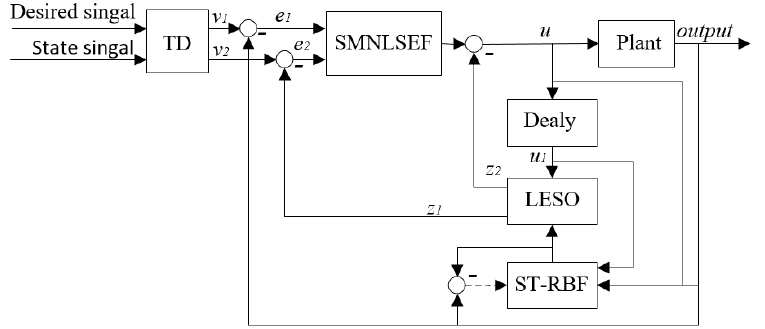
Figure 2. Fault-tolerant aircraft